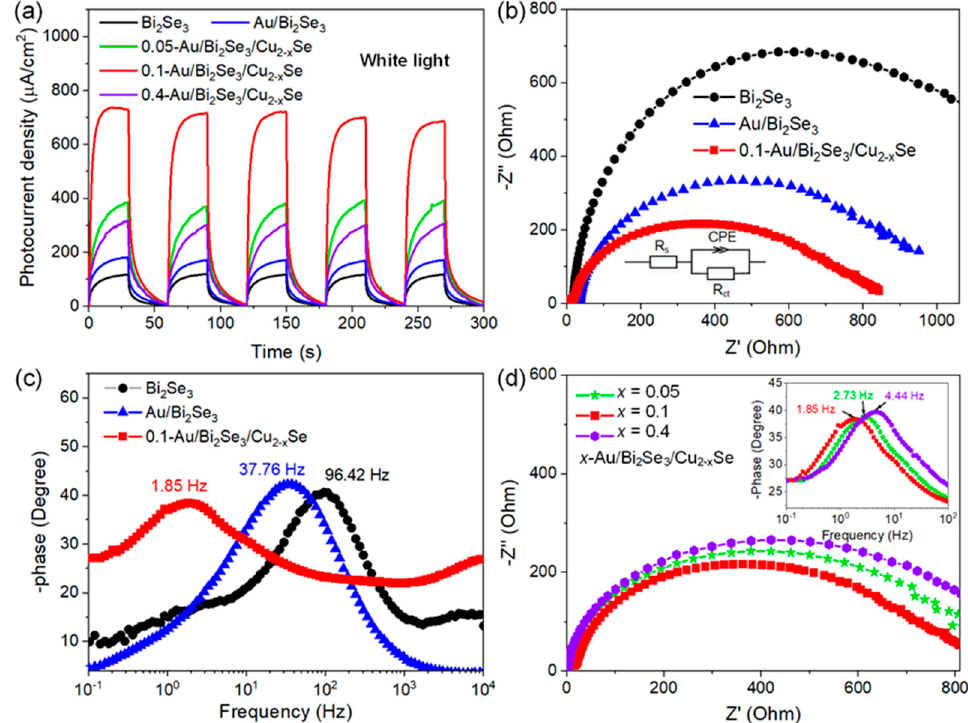
Figure 6. ( a ) Time-dependent photocurrent intensity, ( b ) Nyquist and ( c ) Bode phase plots for FTO photoanodes loaded with Bi 2 Se 3 , Au/Bi 2 Se 3 and x -Au/Bi 2 Se 3 /Cu 2-x Se at 1.23 V vs. RHE with white-light irradiation (AM 1.5 G, 100 mW/cm 2 ). ( d ) Corresponding electrochemical impedance spectroscopy tests for four Au/Bi 2 Se 3 /Cu 2-x Se photoanodes with different initial Cu 2+ concentration.